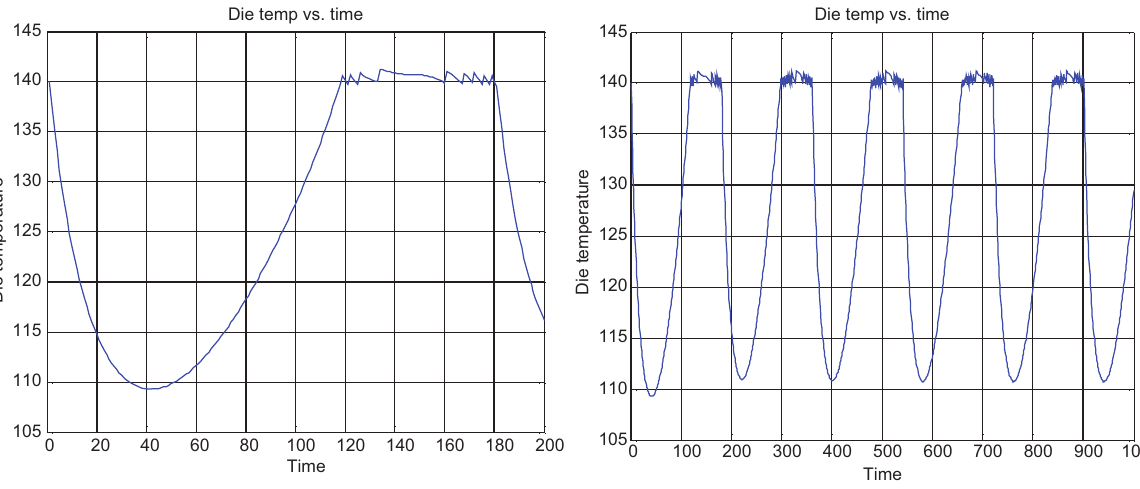
Figure 4 Die temperature variations with time.